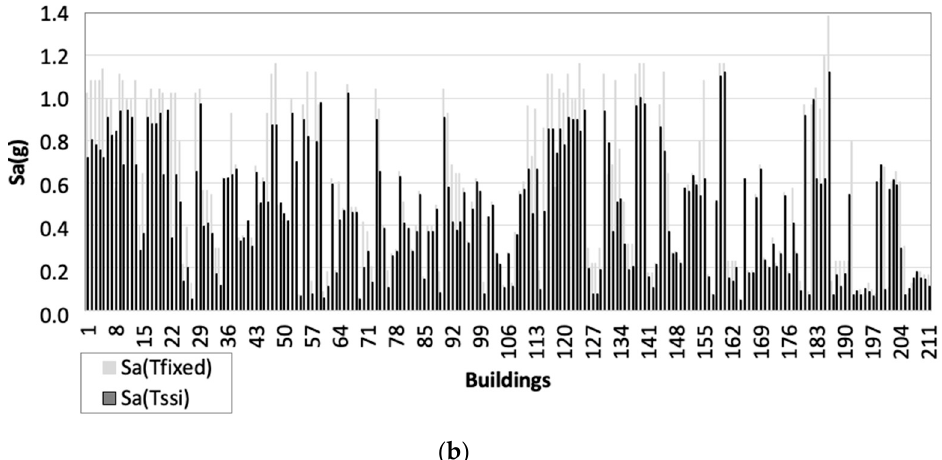
Figure 16. Spectral accelerations S a ( T SSI ) and S a ( T fixed ) evaluated for each building of the northeast area (shown in Figure 19b) for ( a ) 1818 input; ( b ) 2018 input.